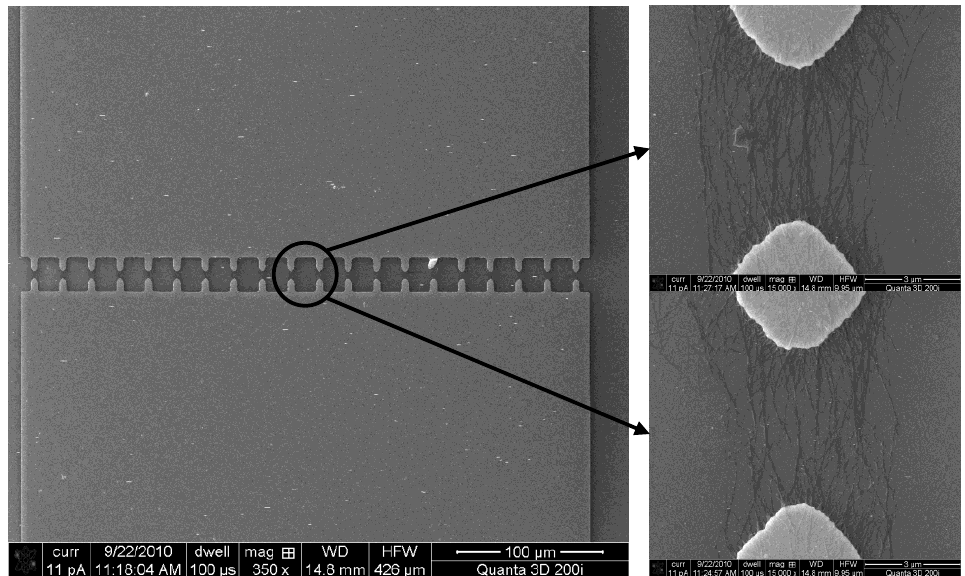
Figure 4. SEM images of the sensor structure and the dielectrophoretically aligned